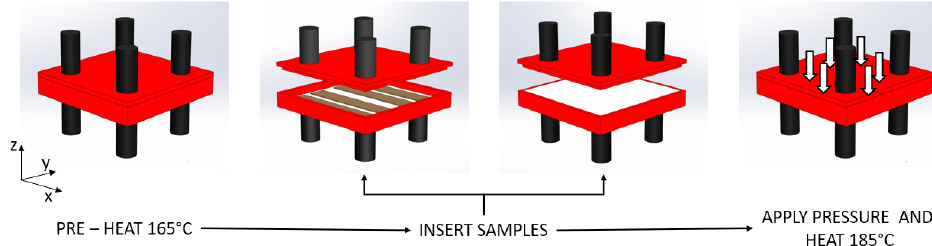
Figure 1. The post-processing